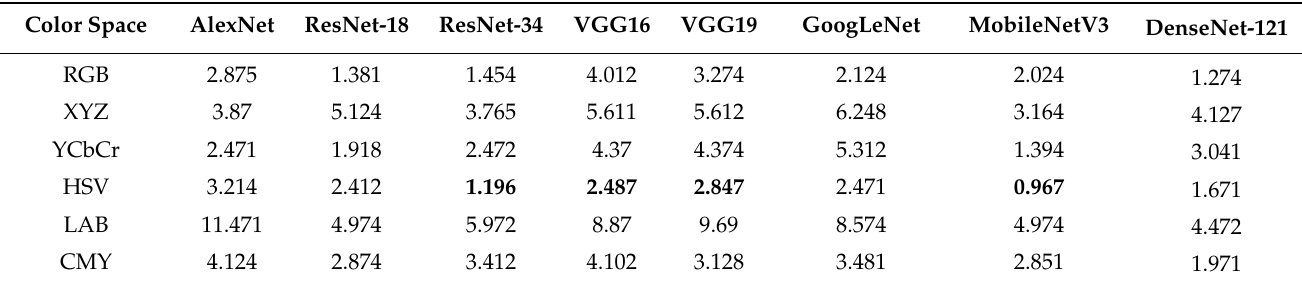
Table 3. Performance of the individual color spaces in terms of